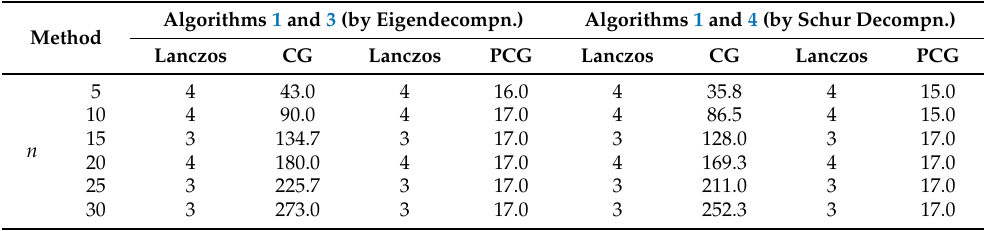
Table 1. Number of iterations of the Lanczos method and the average of numbers of iterations of the CG/PCG method in the case of the 5-th max. singular value of almost symmetric matrix T with a = c = 1 and b = 0.01 in (9) for the shift (8). Algorithms 1 and 3 (by Eigendecompn.) Method